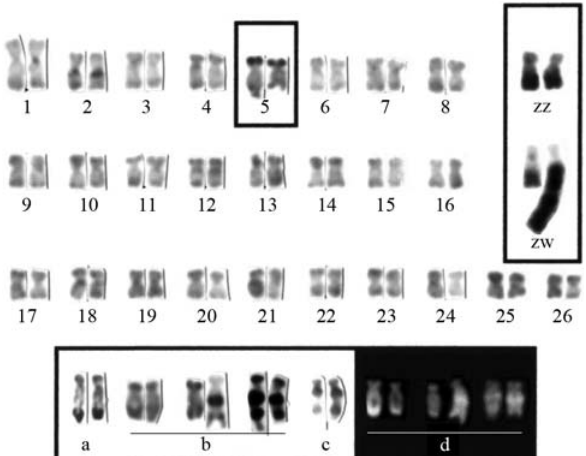
Figure 1 - C-banding patterns in a somatic metaphase of Leporinus elongatus . In the lower frame the three variants of the nucleolar organiz- ing pair (5 th ) found in this species, (a), Ag-NOR site in the C 1 C 1 variant, (b), C-banded C 1 C 1 , C 1 C 2 and C 2 C 2 cytotypes, (c), replication bands in the